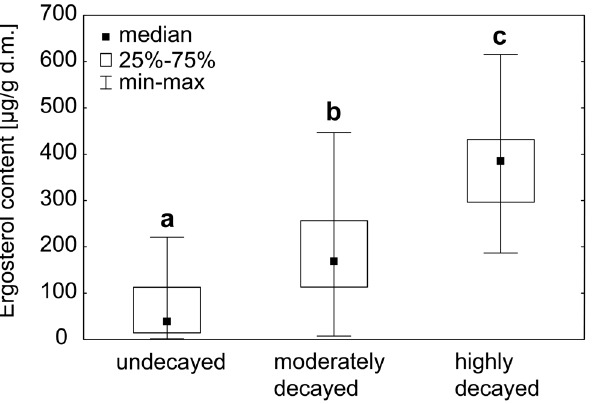
Fig. 5. Changes in the concentration of ergosterol in dead wood along the decay gradient. Boxes bearing different letters denote significant differences in ergosterol content (Kruskal-Wallis test, p , 0.05).